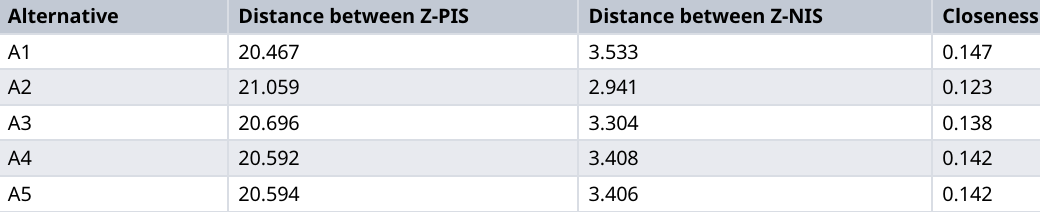
Table 9. Distance and closeness of